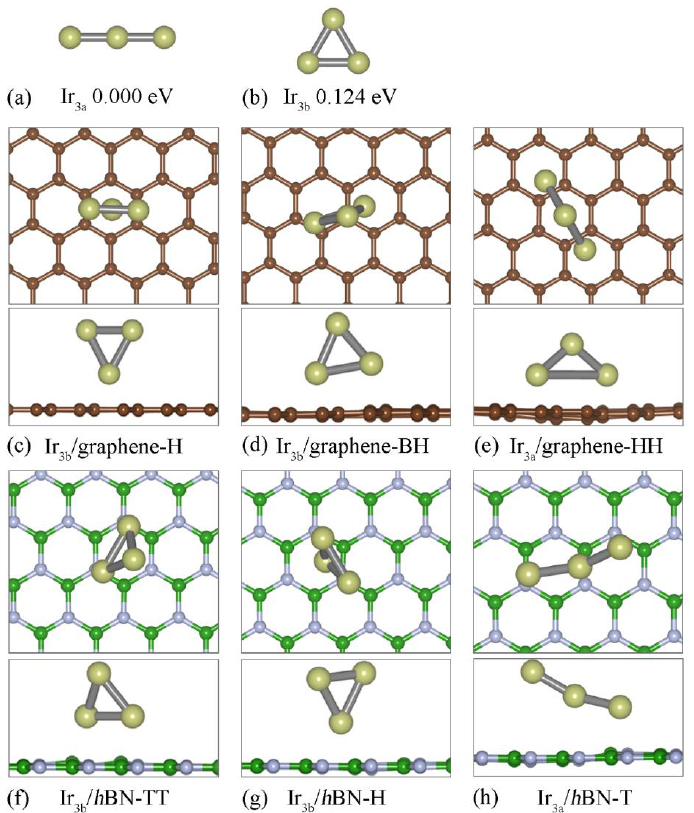
Figure 1. Atomic structures of the ( a ) Ir 3a (line model) and ( b ) Ir 3b (triangle model) clusters. Top and side view of the three relative stable atomic structures of the Ir 3 cluster adsorbed on the graphene ( c – e ) and h BN ( f – h ) substrate, respectively. The Ir, C, B and N atoms are labeled with golden, brown, green and gray balls, respectively. green and gray balls,